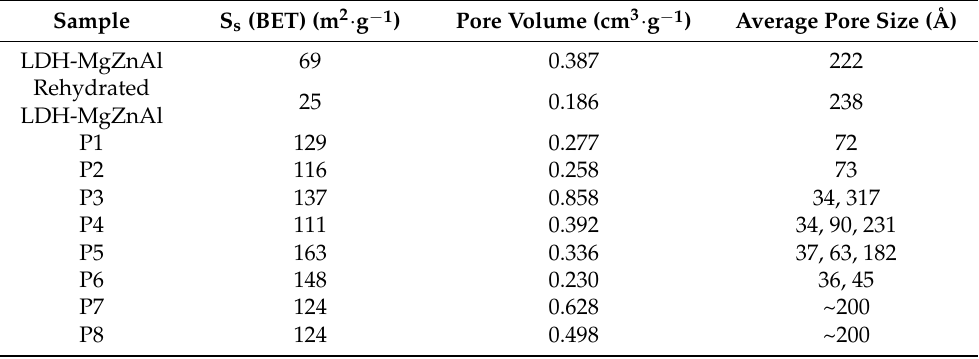
Figure 4. Pore-size distribution ( a ) and adsorption–desorption isotherms ( b ) for the P1–P8 catalysts. Table 3. Surface area, pore volume, and main pore size for LDH, rehydrated LDH, and P1–P8